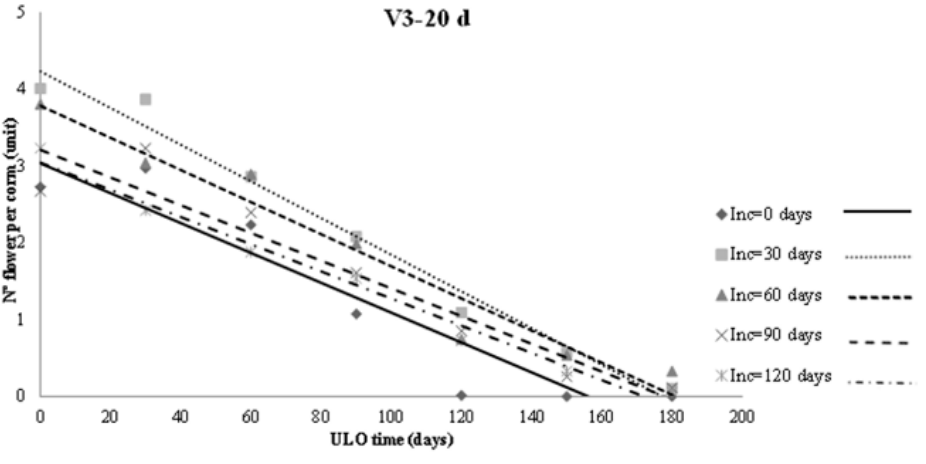
Figure 1. Graph of the weight of saffron per corm (mg) for the different incubation times during the ULO storage, for the different vegetative stages studied (V3–20 d and V3).